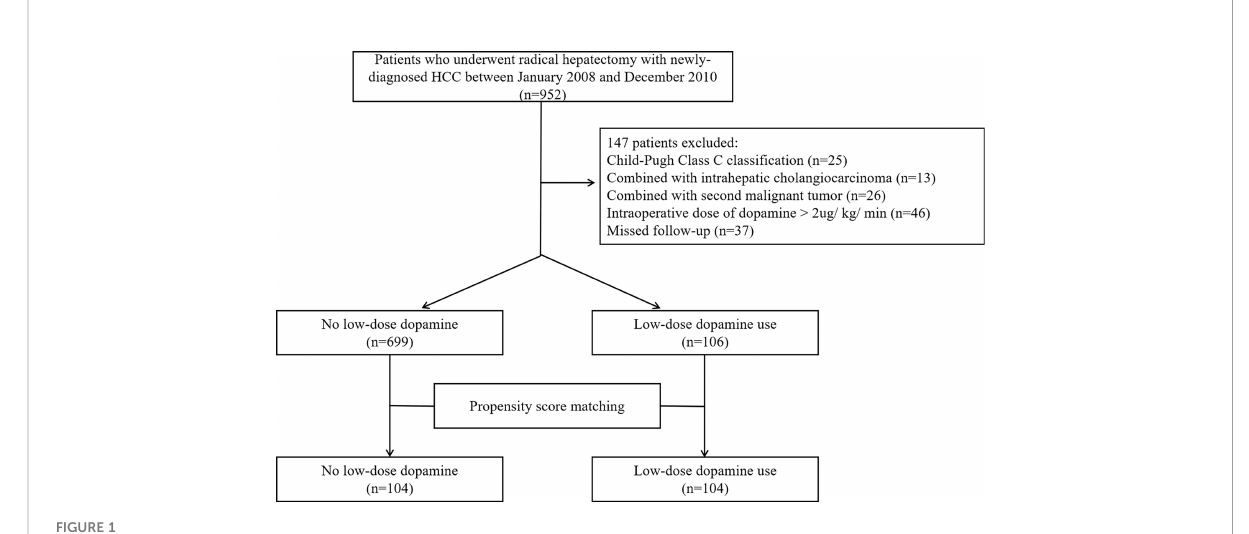
FIGURE 1 Flowchart of the patient